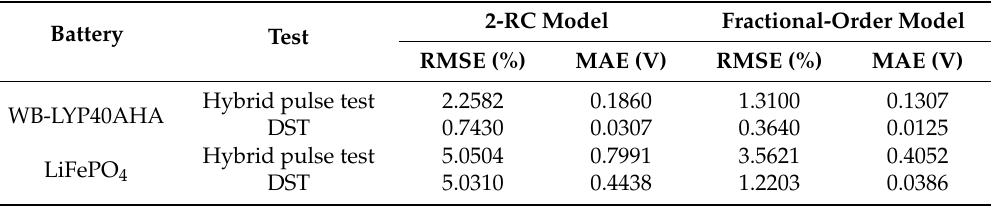
Table 3. RMSEs and MAEs for WB ‐ LYP40AHA and LiFePO 4 battery.